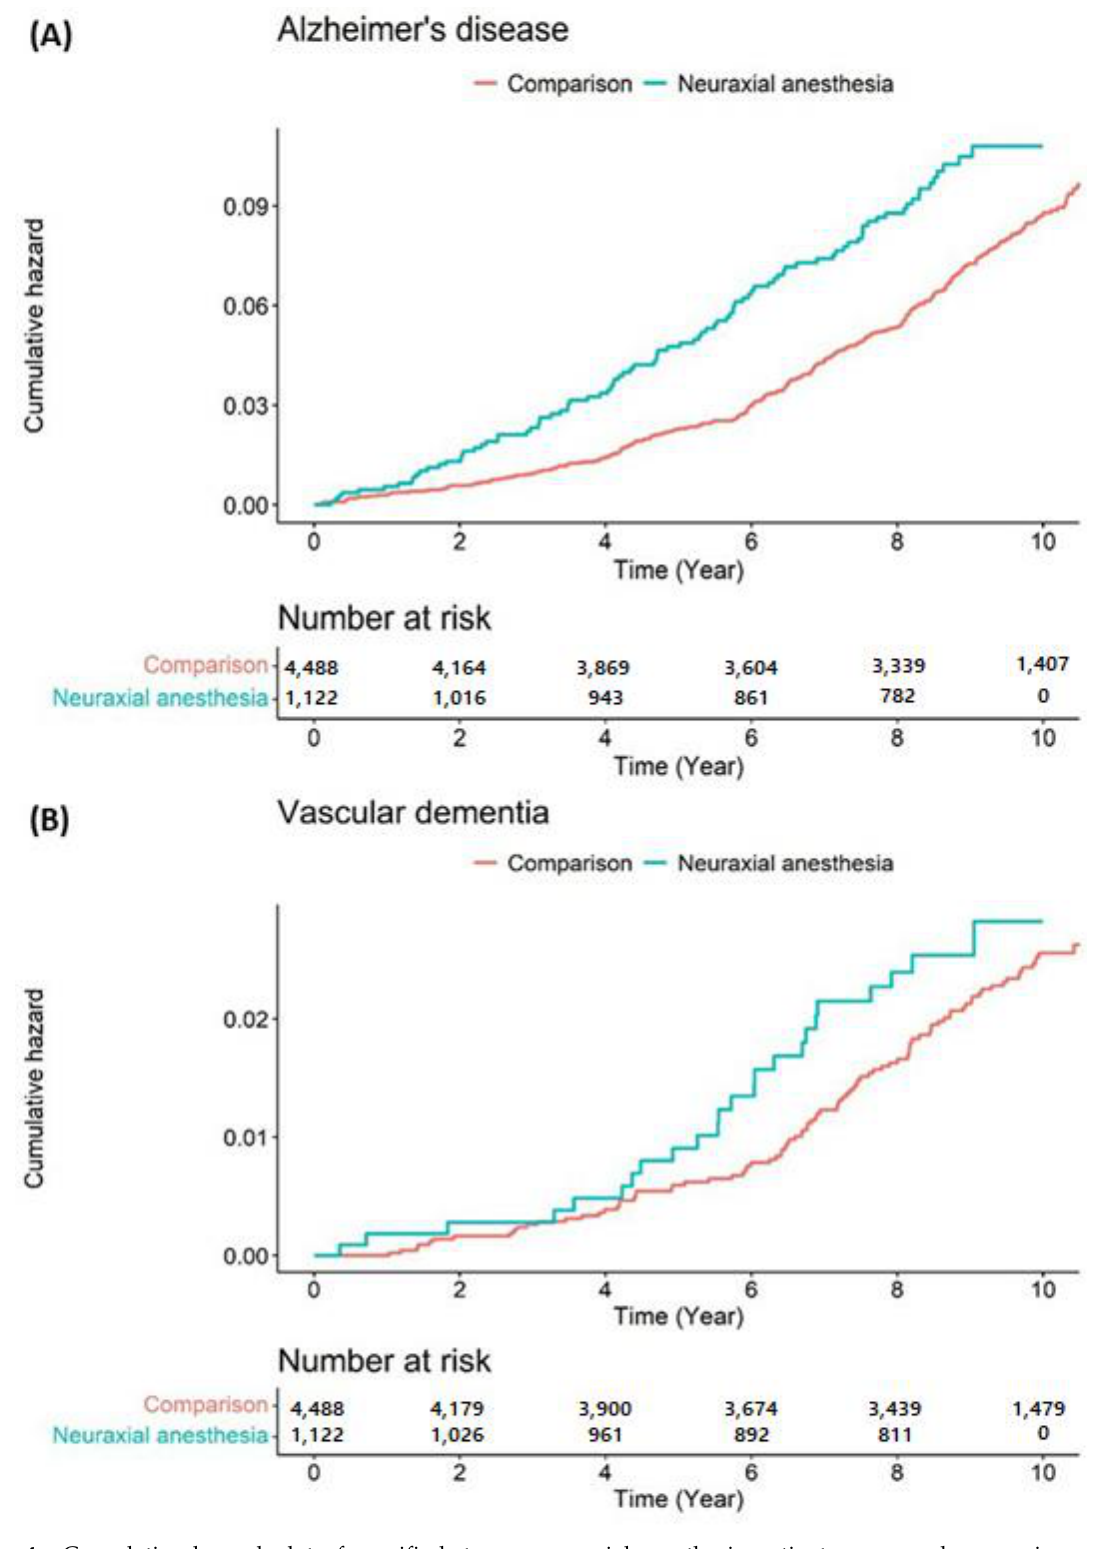
Figure 4. Cumulative hazard plot of specific between neuraxial anesthesia patient group and comparison group: ( A ) Alzheimer’s disease. ( B ) Vascular disease.